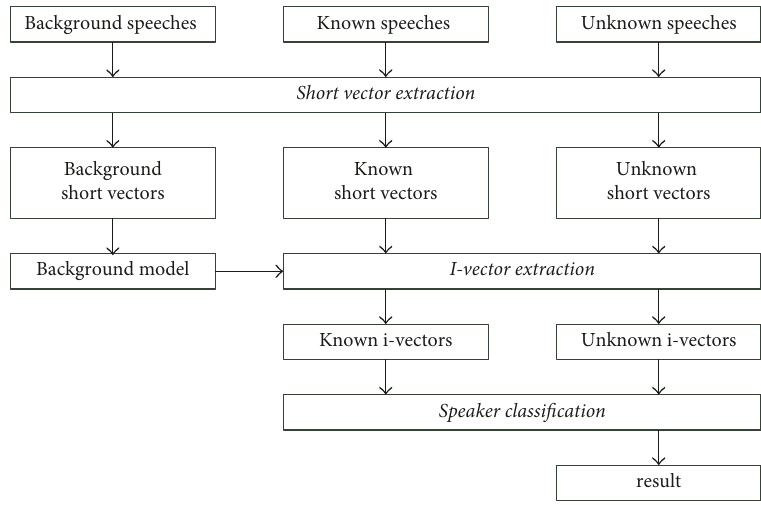
Figure 1: The structure of the speaker recognition using